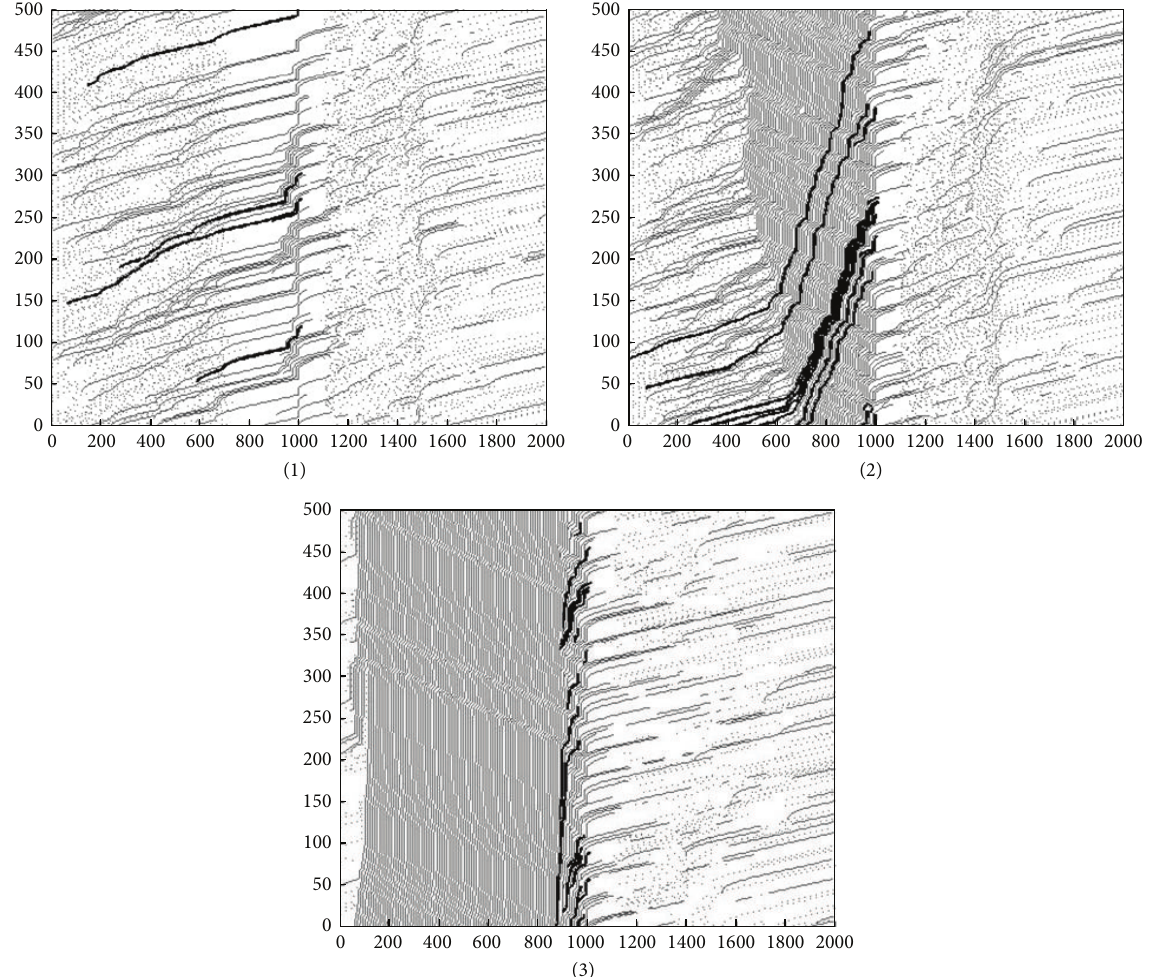
Figure 6: Space-time diagram for pulling out of bus stops. (1) 𝑅 = 0.15, (2) 𝑅 = 0.2, and (3) 𝑅 = 0.3